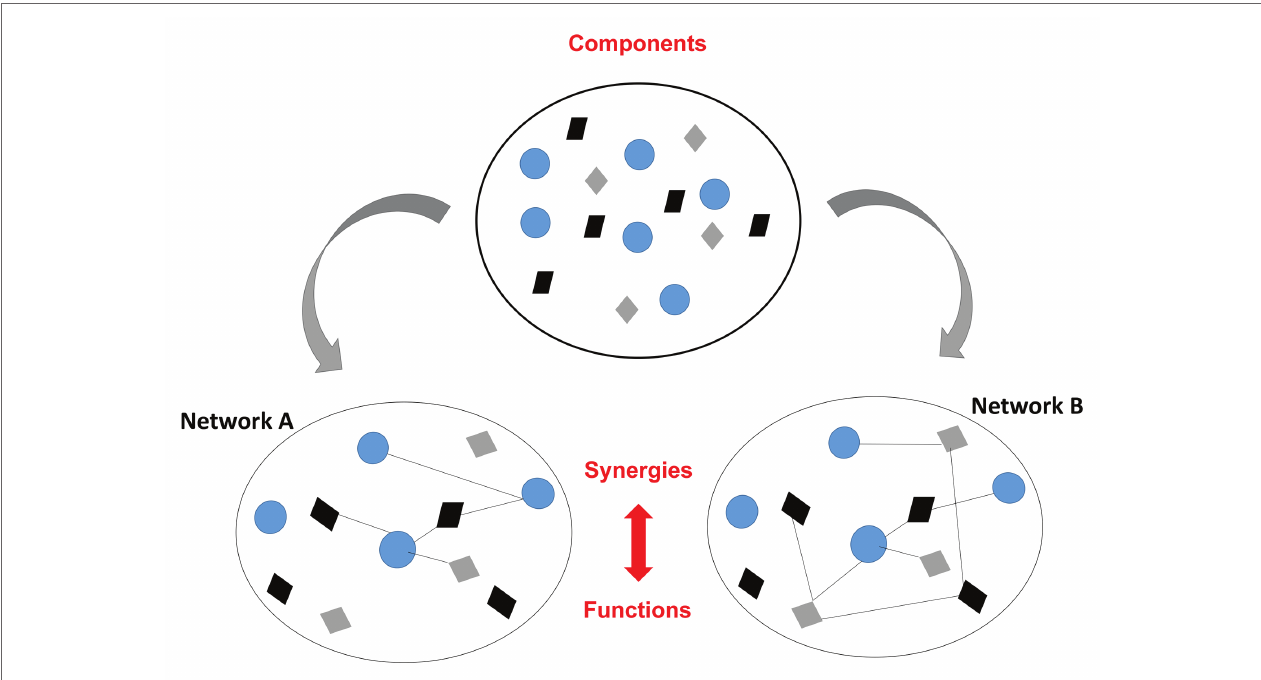
FIGURE 2 | Formation of synergies across levels to satisfy task goals during exercise. Up: representation of different types of components of a certain physiological network. Down: system components, coupled by links, reorganize to form different structural and functional synergies (A,B) to achieve the same task goal under changing constraints. Network components are represented by symbols and their links through black